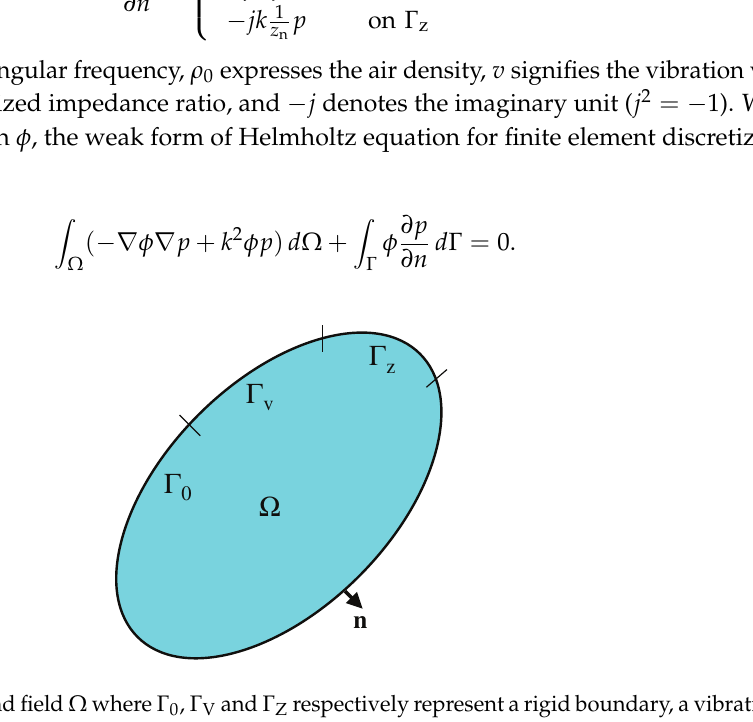
Figure 1. Interior sound field Ω where Γ 0 , Γ V and Γ Z respectively represent a rigid boundary, a vibration boundary, and an impedance boundary. In addition, n is the outward